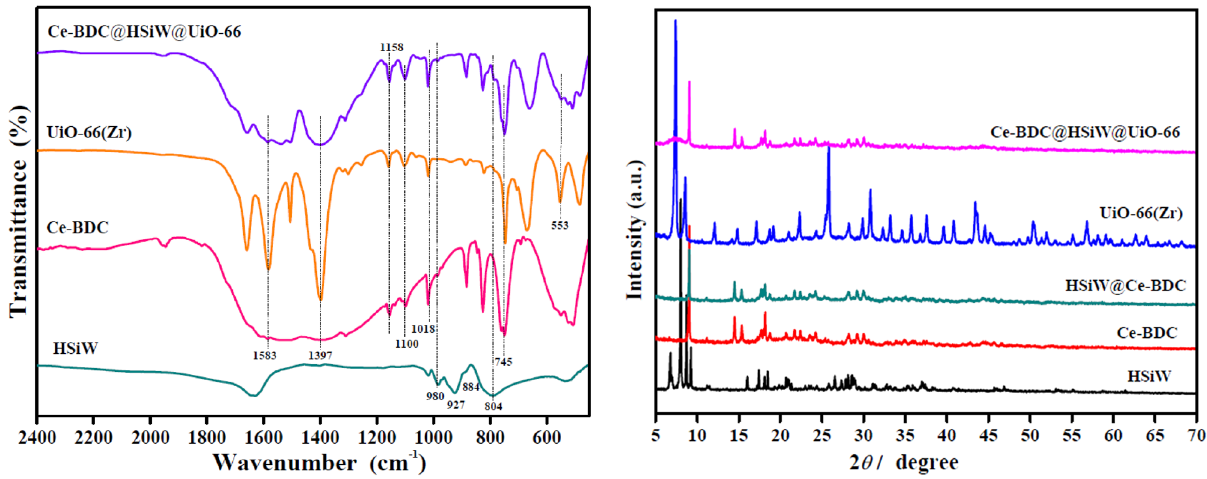
Figure 1: FTIR spectra of HSiW, Ce - BDC, UiO - 66 ( Zr ) , and Ce - BDC@HSiW@UiO - 66 hybrids.